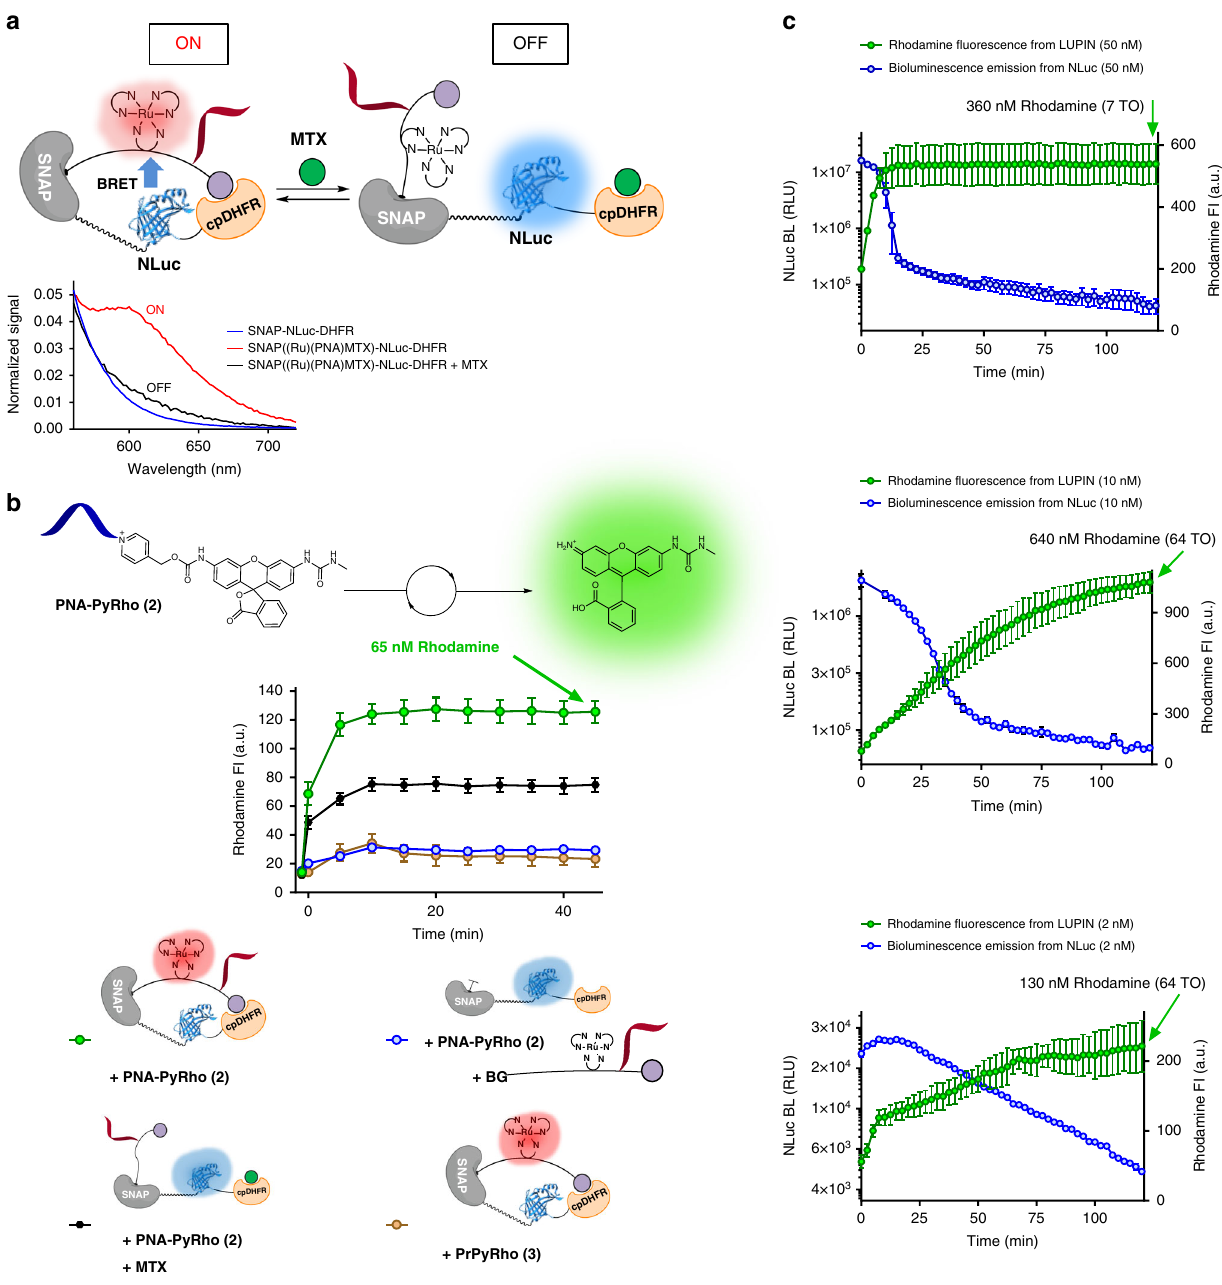
Fig. 2 Characterization of LUPIN. a Bioluminescence resonance energy transfer from Nluc to ruthenium is observed when SNAP-NLuc-DHFR was labeled with BG-(Ru)(PNA)-MTX ( 1 ). Emergence of a new band at 610 nm indicates BRET from Nluc to ruthenium (red line); in the presence of methotrexate, more of the sensor shifts into the open conformation, decreasing BRET ef fi ciency (black line). b Fluorescence enhancement due to rhodamine uncaging by the LUPIN system is observed. In the presence of methotrexate, the reaction is partially inhibited due to lower BRET ef fi ciency. In the absence of nucleic acid template, or in the absence of a covalent link between the synthetic linker and the protein construct, the reaction is marginal. Reaction conditions: SNAP-NLuc-DHFR labeled with BG-(Ru)(PNA)-MTX ( 1 ) (50 nM), PNA-PyRho ( 2 ) or PrPyRho ( 3 ) (0.5 µ M), sodium ascorbate (10 mM), furimazine (100 µ M), and methotrexate (100 µ M). BG benzyl guanine. c Varying the concentration of the labeled SNAP-NLuc-DHFR protein (50, 10, and 2 nM) has a signi fi cant impact on luminescence decay and the rate of rhodamine release (Fig. 3): raloxifen, a partial agonist of the estrogen receptor; 23,24 a heteroatom involved in the binding to the target was selected for ibrutinib, a potent covalent kinase inhibitor (IC 50 of 3 – 6 nM in conjugation to the pyridinium linker, thus abrogating its designed chronic active BCR signaling B-cell lymphoma 25 ); and a duo- activity and yielding a caged prodrug. The photocatalyzed carmycin analog, a highly cytotoxic prodrug of a DNA-alkylating uncaging of the prodrug was validated through a templated agent with IC 50 < 1 nM in human bronchial carcinoma cells 26 . reaction using LED irradiation (Fig. 3). These experiments We prepared drug conjugates by attaching each drug to the showed a clean conversion of the caged prodrug to the active drug pyridinium linker and 5-mer PNA (Fig. 3, 6 – 8 ). In all three cases, within minutes of irradiation. 4 NATURE COMMUNICATIONS| (2018) 9:3539 |DOI: